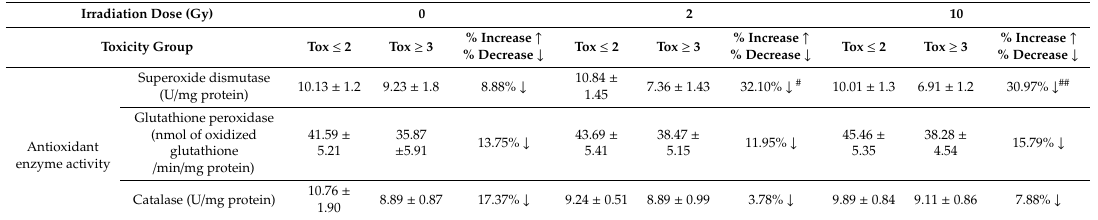
Table 4. Antioxidant enzyme activities in erythrocyte lysates in both groups of patients. Groups Tox ≤ 2 and Tox ≥ 3 correspond to patients presenting grade 2 or less and grade 3 or more of late skin reactions after RT according to RTOG / EORTC, respectively. Percentages of increase and decrease were calculated to compare Tox ≥ 3 vs. Tox ≤ 2 group. # for p < 0.05 and ## for p < 0.005 for Tox ≥ 3 compared to Tox ≤ 2 group.